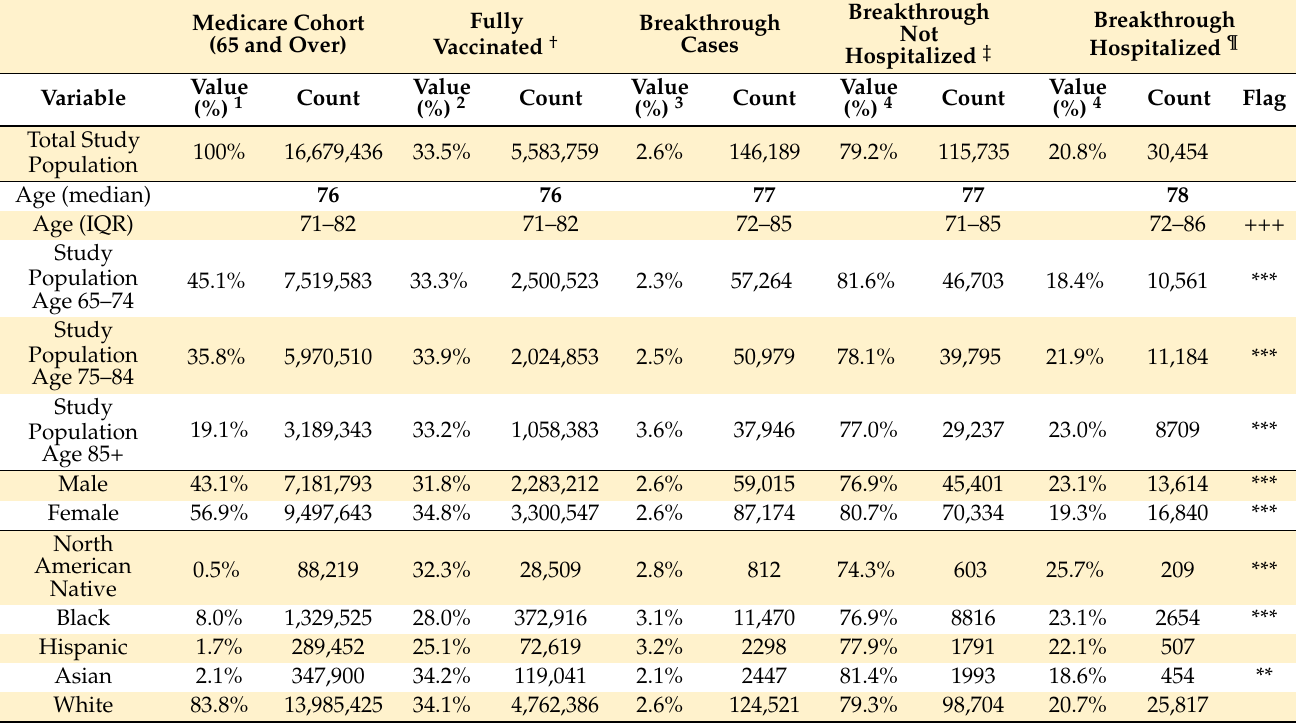
Table 1. Study Cohort: Demographic, Clinical and Socioeconomic